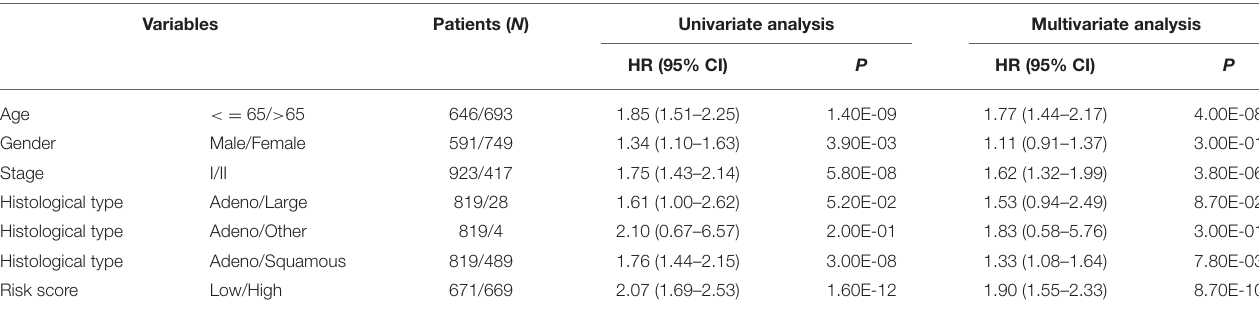
TABLE 4 | Univariate and multivariate Cox regression analyses of the gene signature and overall survival of NSCLC patients in entire cohort. Variables Patients ( N